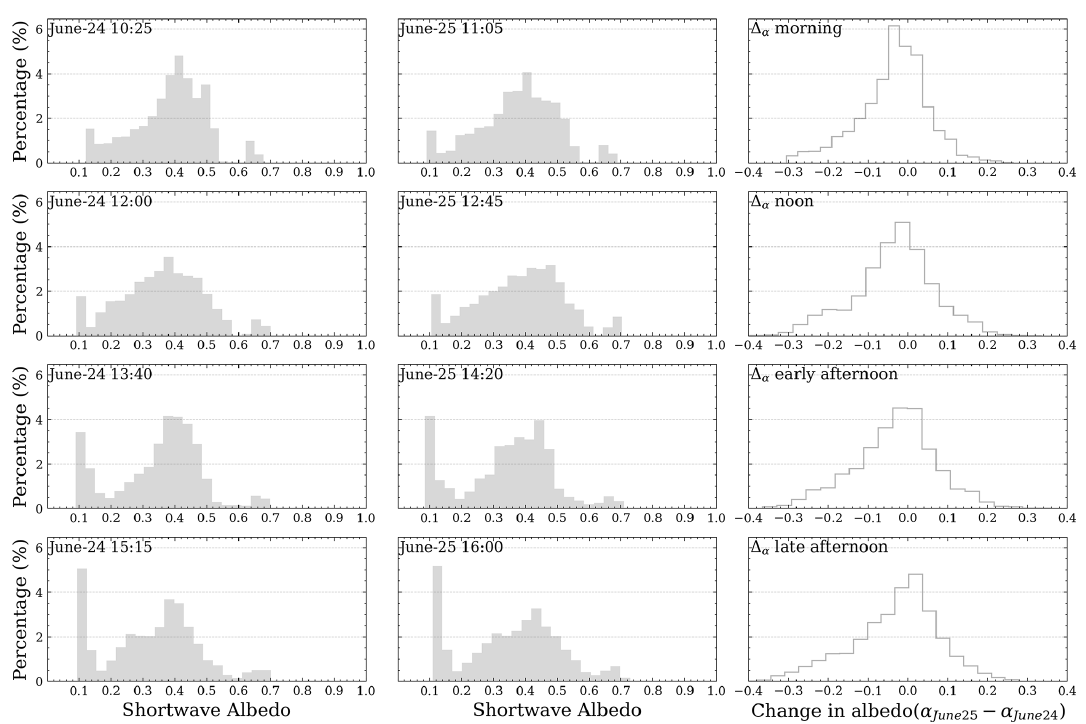
Figure 11. Histogram of the distribution of albedo values observed during the eight MODIS overflights on 24–25 June. The albedo histograms for 24 June ( α 24 ) and 25 June ( α 25 ) and the difference ( (cid:49) α = α 25 − α 24 ) are shown in the columns from left to right. From top to bottom, the rows represent the four satellite overpasses that occurred throughout the day: in the morning, at midday, in the early afternoon, and in the late